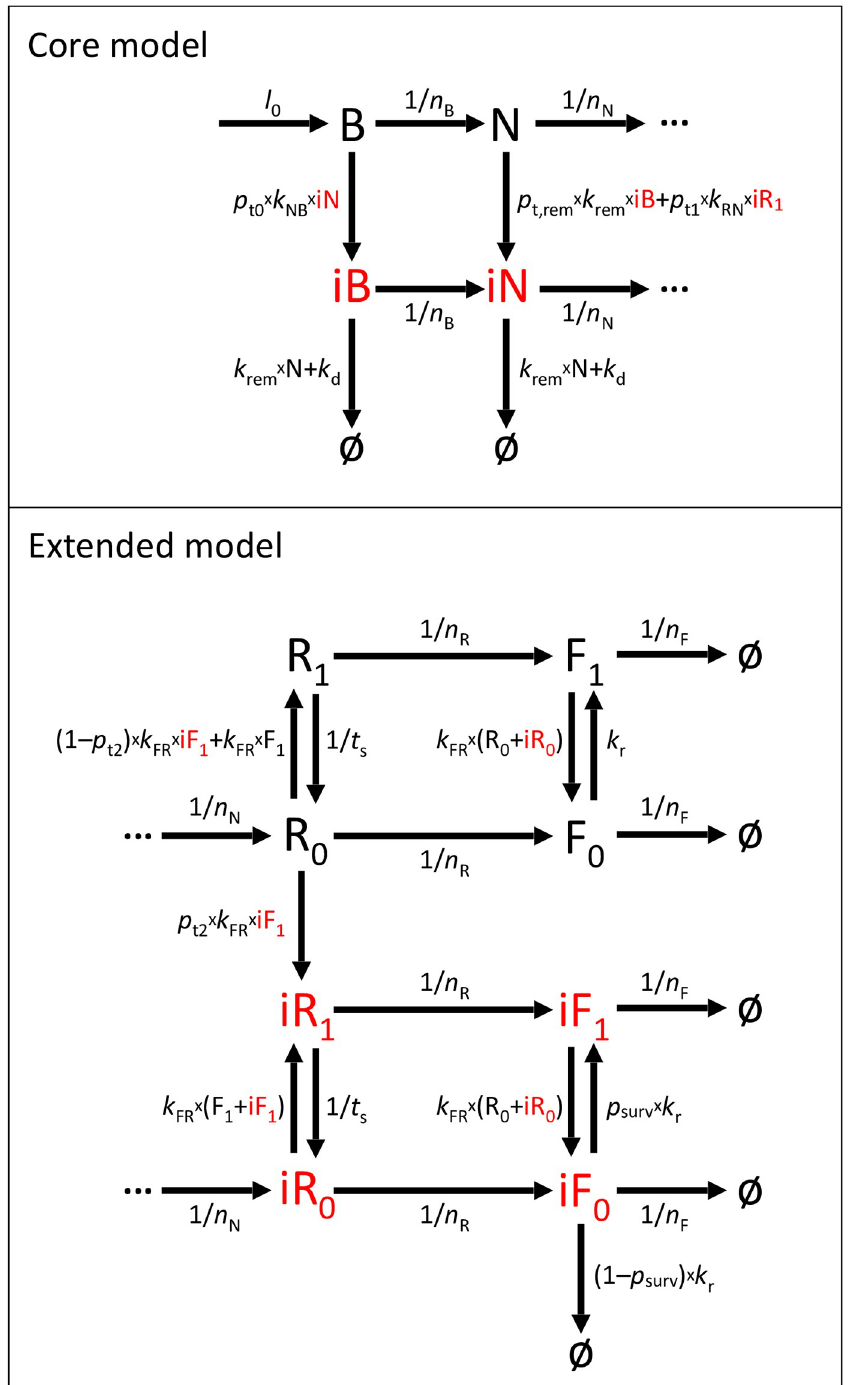
Fig 1. Model diagram. Upper: Core model. Lower: Extended model. The diagram illustrates class (horizontal arrows) and state (vertical arrows) transitions of honeybees. The queen produces new brood (B). As bees are older, they change their classes from brood (B), nurses (N), nectar-receivers (R 0 and R 1 ), to foragers (F 0 and F 1 ). Bees can change into an infection state (iB, iN, iR 0 , iR 1 ) with a certain probability if they receive nectar from infected ones. Nectar-receivers and foragers can also change their nectar-loaded state between unloaded (subscript 0) and loaded (subscript 1). φ represents ‘death’. See the main text for a more detailed description of each transition. The full model is composed of both core and extended